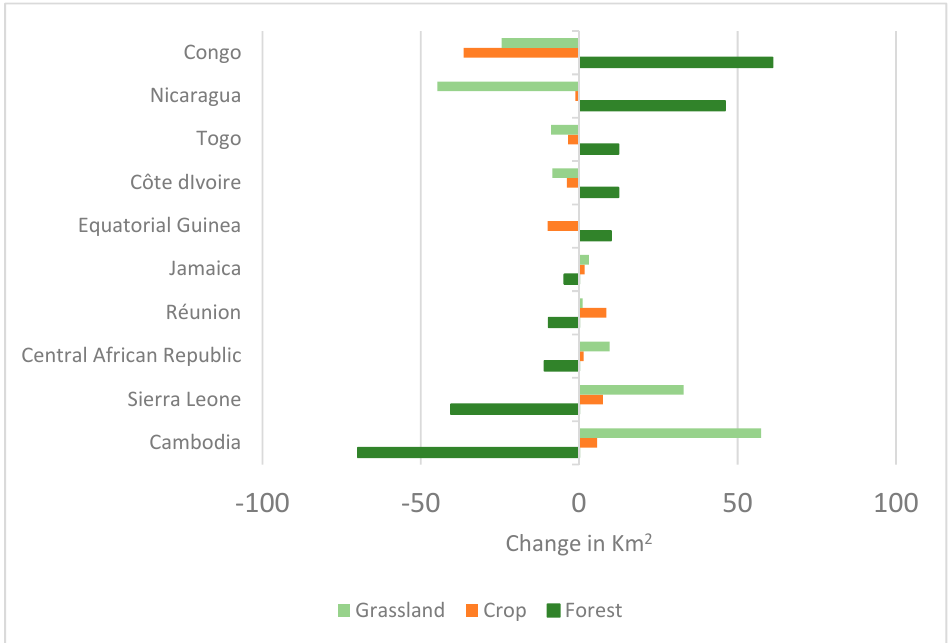
Figure 7. Land cover changes in mountain areas in selected countries where MGCI did not change from 2015 to 2018.